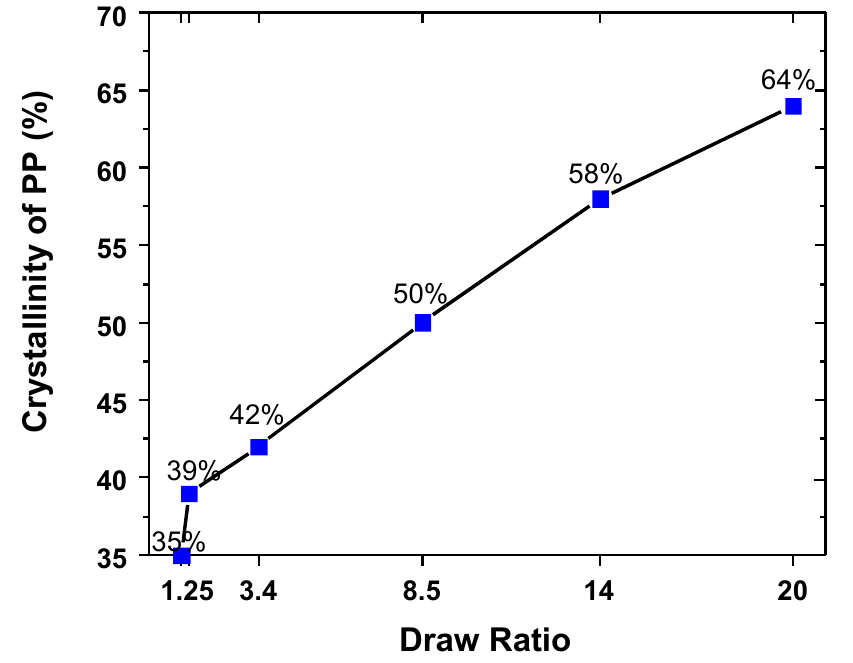
Figure 9. Overall crystallinity of PP as a function of draw Figure 9. Overall c rystallinity of PP as a function of draw ratio.